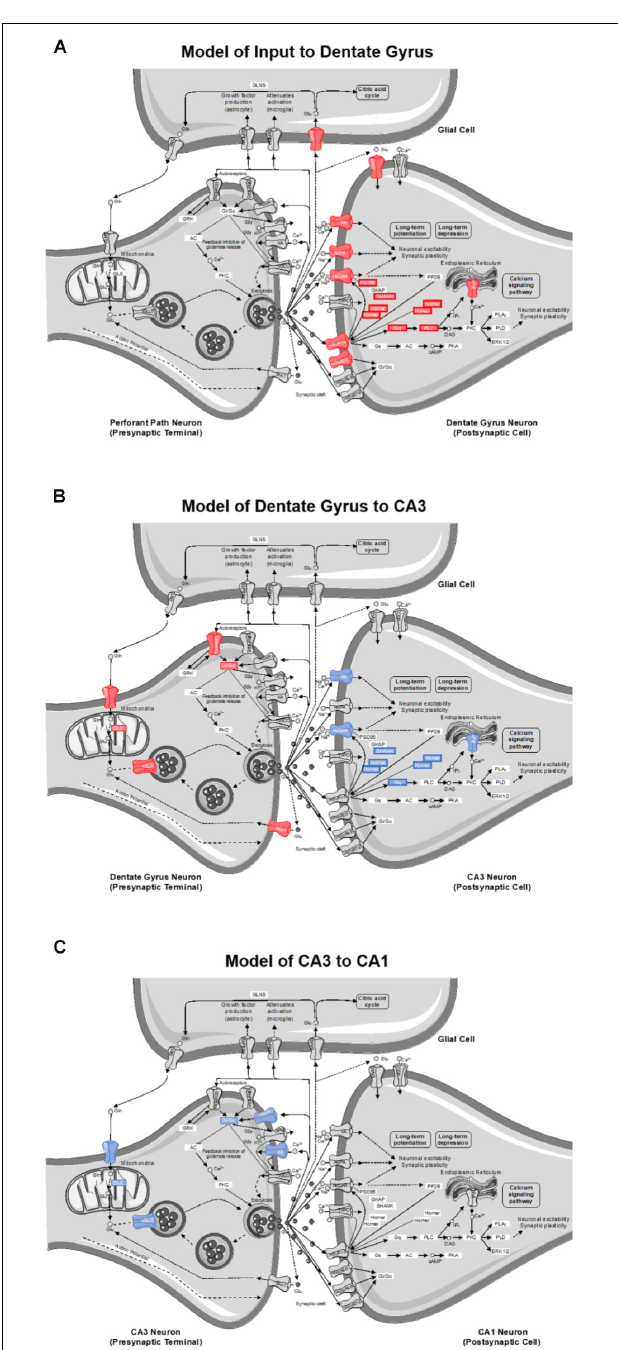
FIGURE 8 | Model of gene contributions to significant ionotropic glutamate receptor (glutamatergic synapse; KEGG) pathway enrichment as determined by DAVID for (A) inputs to the DG, (B) projections from DG to CA3, and (C) projections from CA3 to CA1. Significant reductions in receptors/genes by diet (red) and age (blue) are indicated by